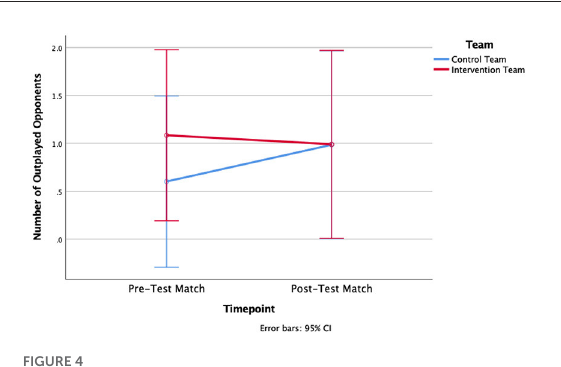
FIGURE4 Differences in Number of Outplayed Opponents (NOO) between Pre-and Post-test matches for the Control Team and the Intervention Team.